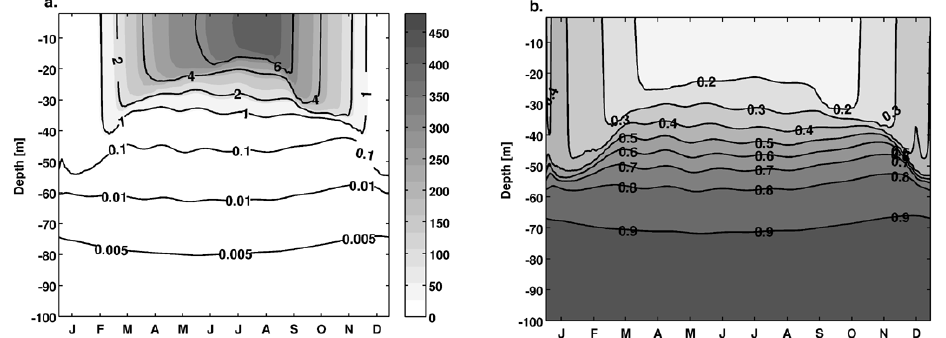
Fig. 2. Ratio between methyl iodide and primary production rate k PP in Opt4 ( a , grey shaded area, [mmol CH 3 I ( kmolP ) − 1 ]), its relation k PPOpt4 ) ( a , contour lines), and the nutrient limitation factor N lim (b) to k PP in Opt1 (i.e. k PPOpt1